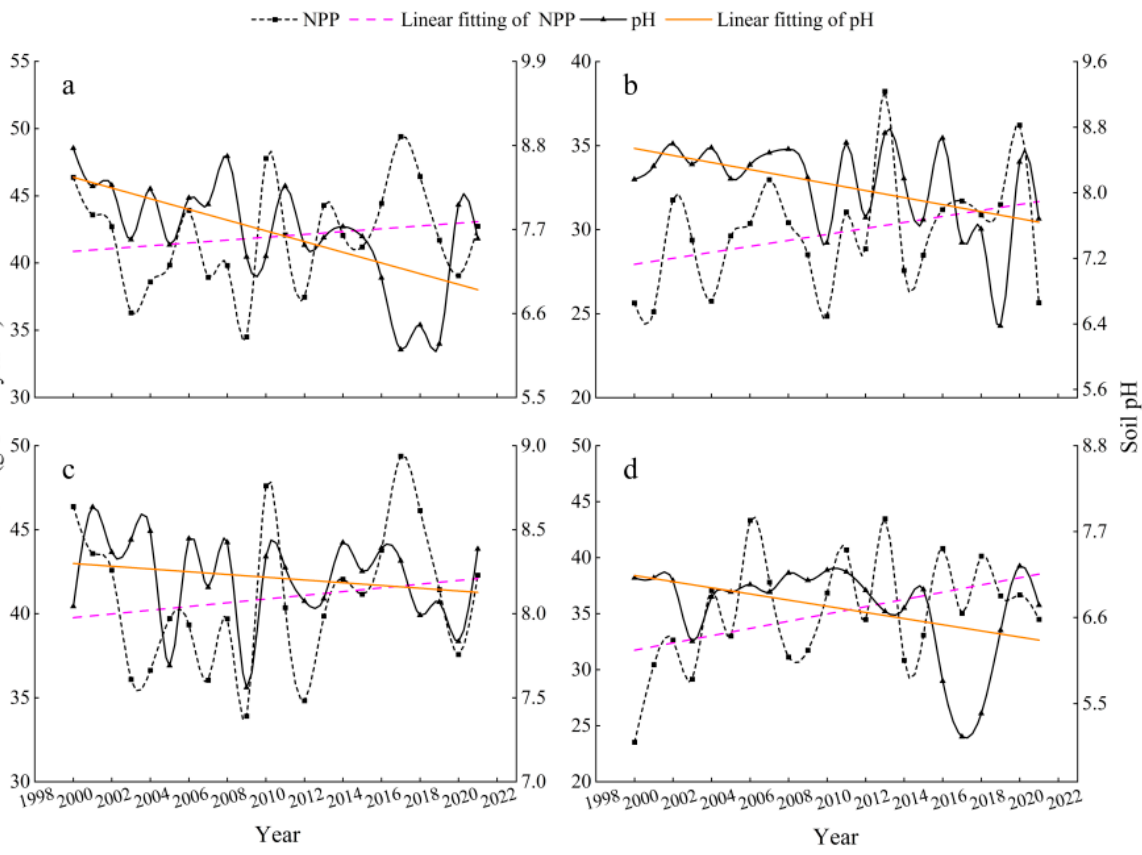
Figure 3. Interannual variations of pH and NPP during 2000–2021: ( a ) pH and NPP in summer, ( b ) pH and NPP in June, ( c ) pH and NPP in July, and ( d ) pH and NPP in August.